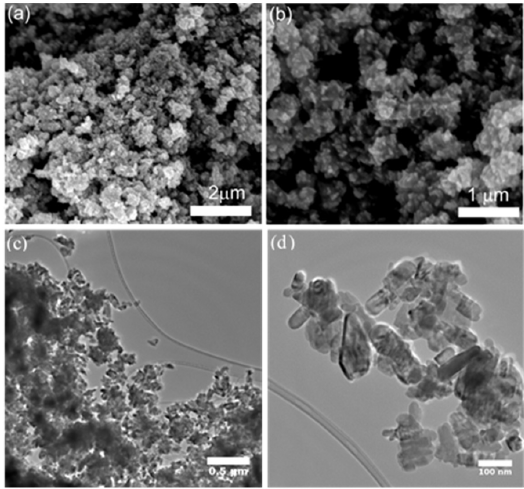
Figure 2. ( a , b ) NfsOZn morphology using electron microscopy scans. ( c , d ) NfsOZn morphology using electron microscopy transmission.